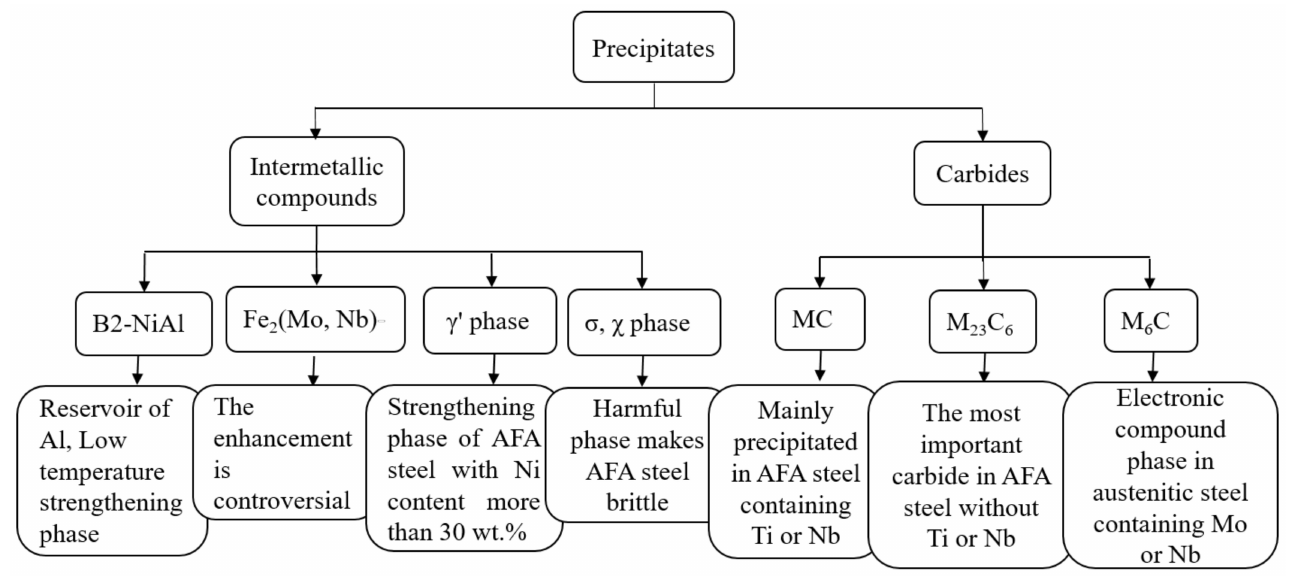
Figure 2. Precipitates in AFA steel at high temperatures.